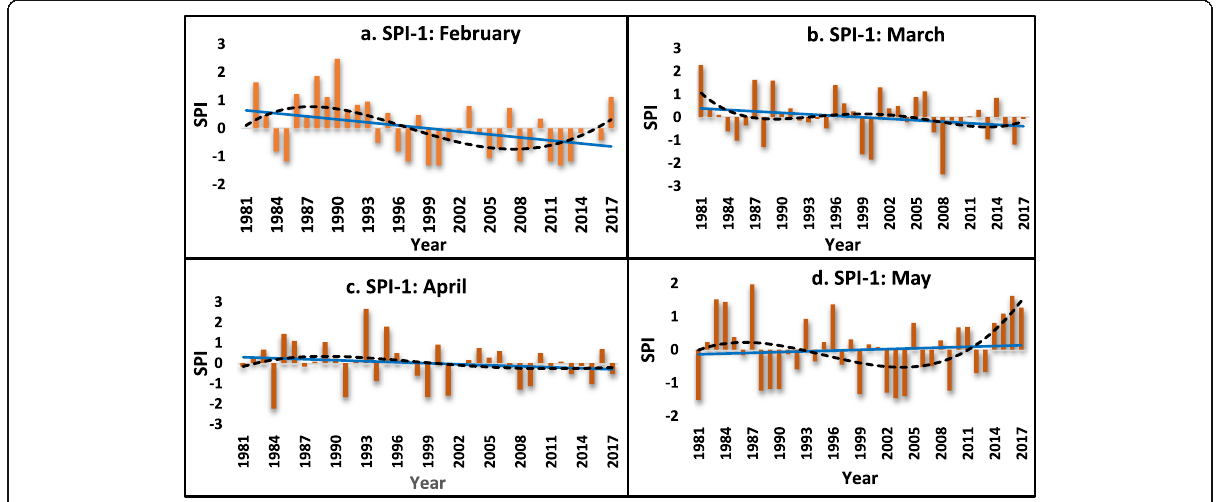
Fig. 2 SPI 1-month anomalies and trends of belg rainy months: ( a ) SPI-1: February; ( b ) SPI-1: March; ( c ) SPI-1: April; ( d ) SPI-1: